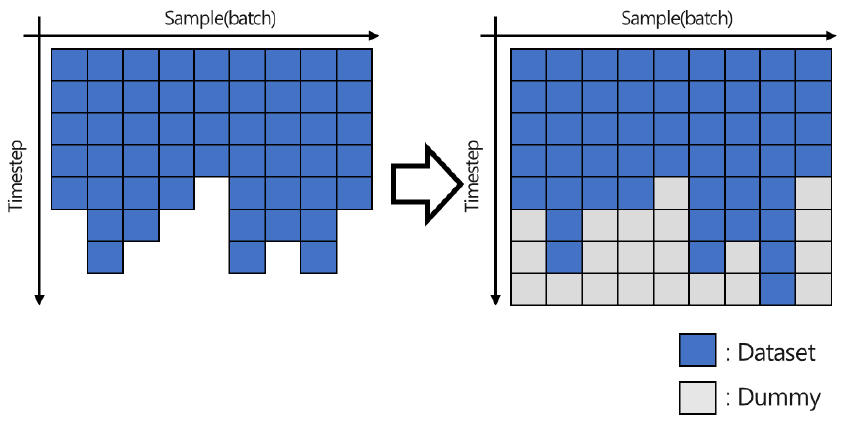
Figure 2. Conceptual structure of the padding method.